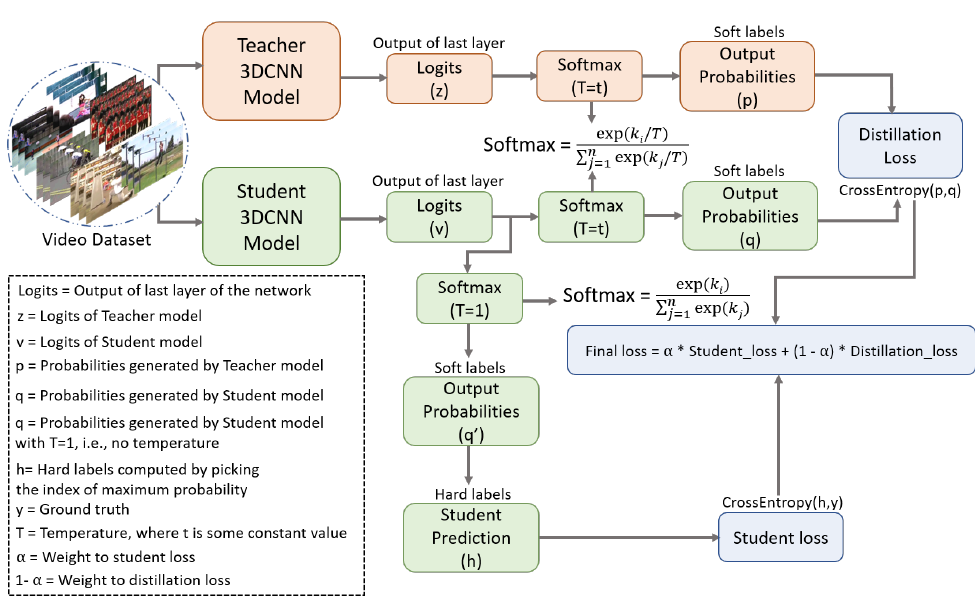
Figure 4. The workflow diagram of the proposed spatio-temporal knowledge distillation method using offline distillation